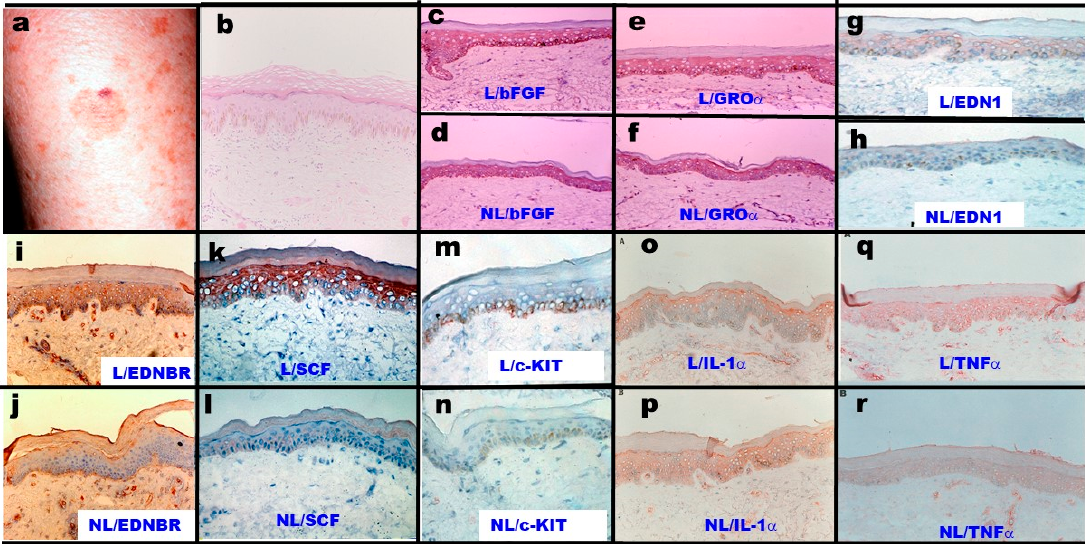
Figure 1. Clinical appearance of SLs and the immunochemistry of SLs and non-lesional skin with antibodies to various melanogenic cytokines and receptors [2,4]. L: Lesion, NL: Non-lesion. ( a ) Clinical appearance of SLs on the forearm; ( b ) Hemoxylin & Eosin staining; ( c , d ) Immunohistochemistry with anti-bFGF; ( e , f ) Immunohistochemistry with anti-GRO α ; ( g , h ) Immunohistochemistry with anti-EDN1; ( i , j ) Immunohistochemistry with anti-EDNBR; ( k , l ) Immunohistochemistry with anti-SCF; ( m , n ) Immunohistochemistry with anti-c-KIT; ( o , p ) Immunohistochemistry with anti-IL-1 α ; ( q , r ) Immunohistochemistry with anti-TNF.